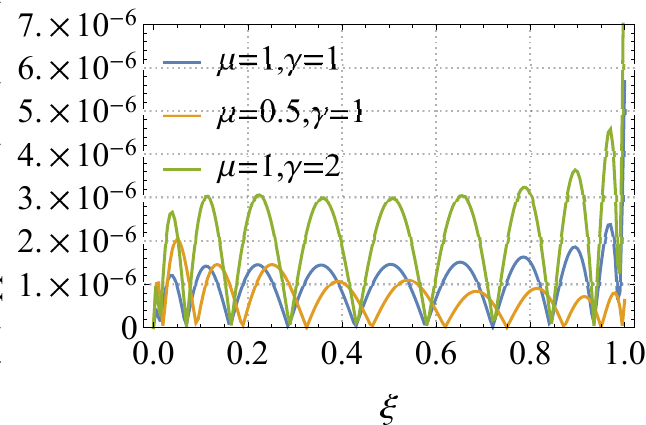
Figure 2. Graph of the absolute error between the exact and the approximate solutions of Model 1 when α = 0.3 and m = 6, and for different values of µ and γ